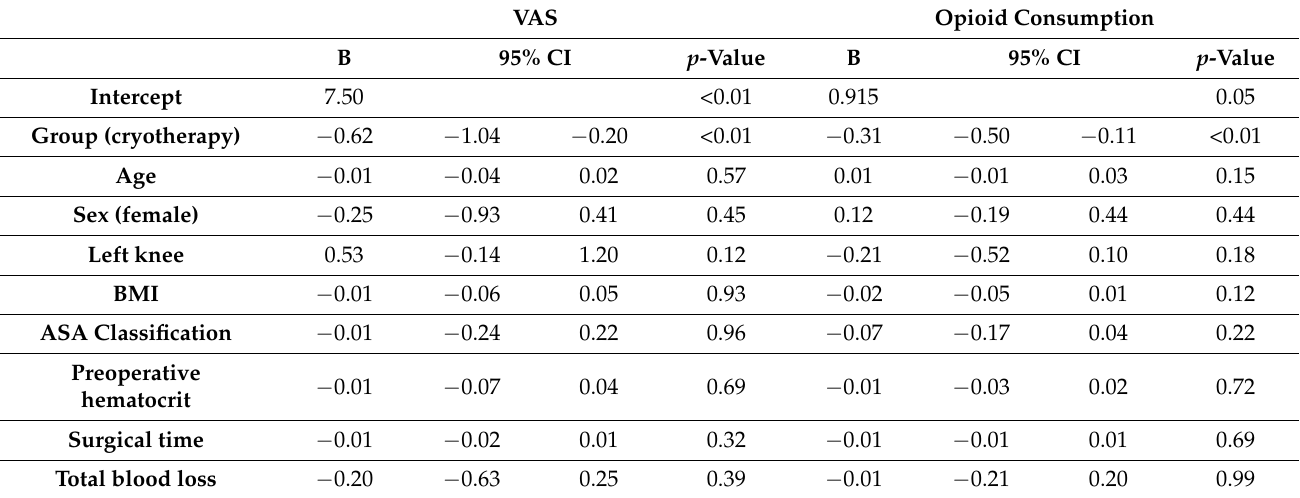
Table 4. Multiple linear regression models for postoperative VAS and opioid consumption. VAS Opioid Consumption B 95%